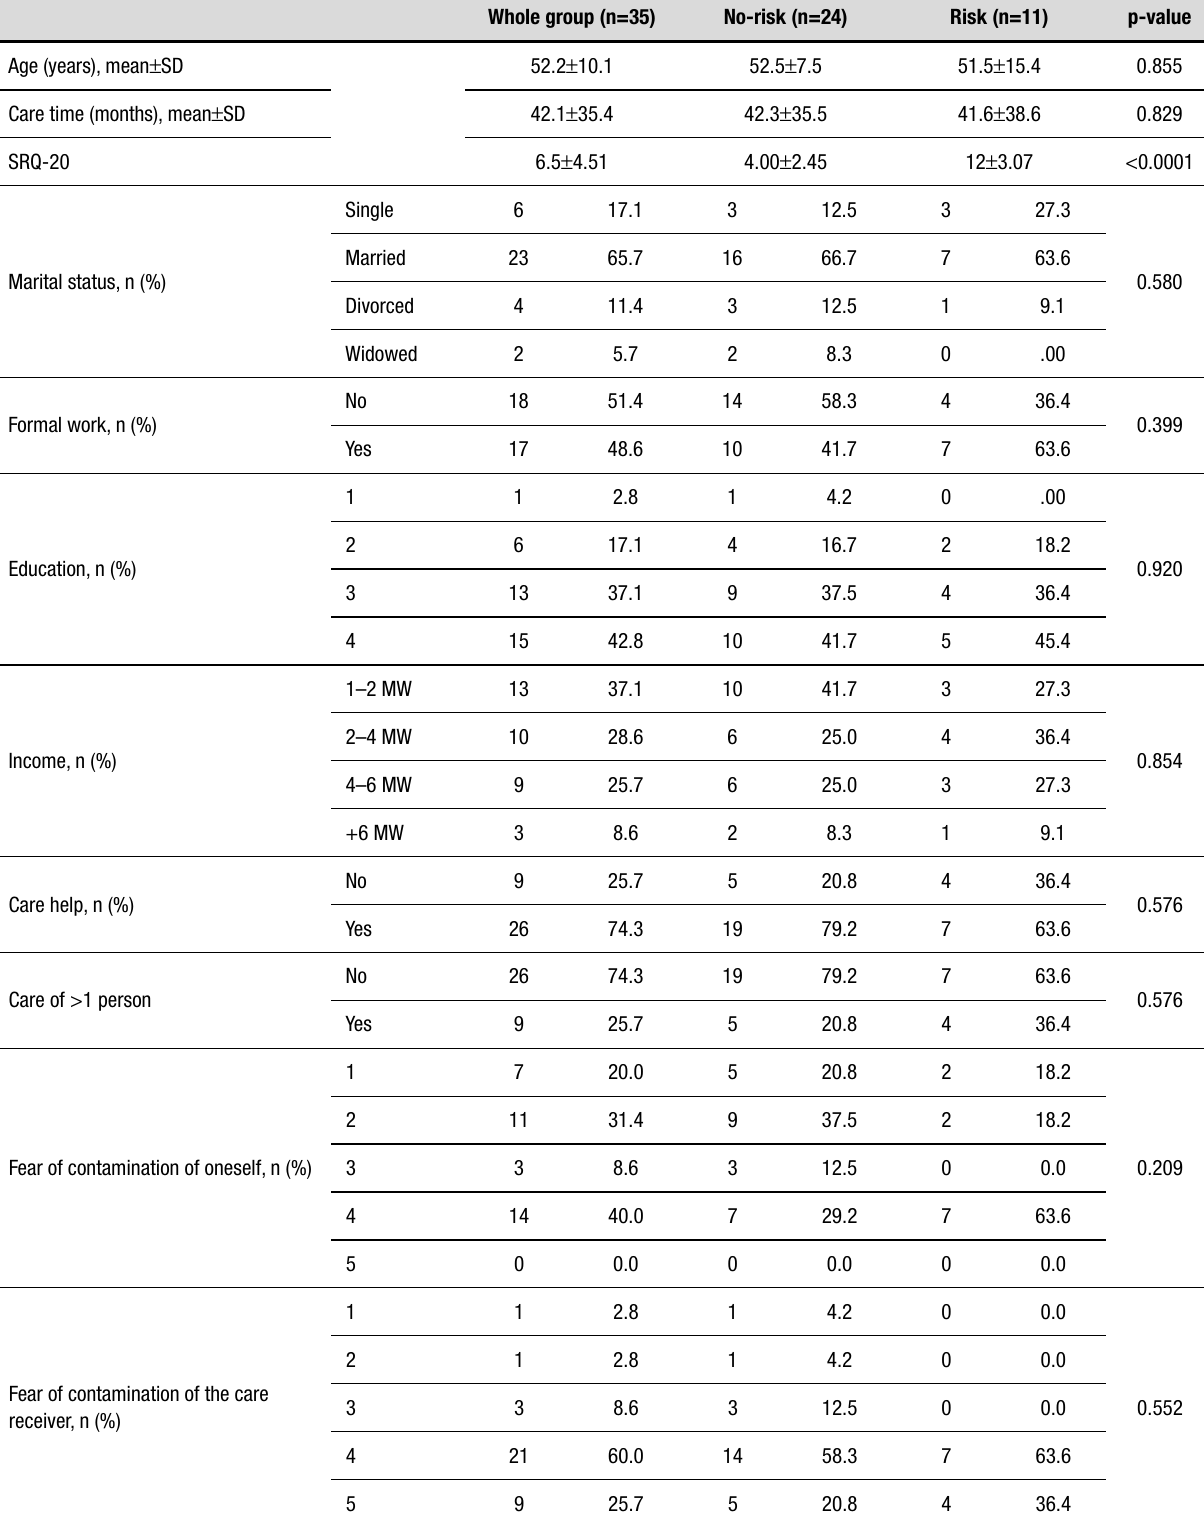
Table 1. Variables relating to the characteristics of the caregiver to the whole group and according to the risk classification defined by the SRQ-20 instrument (No-Risk and Risk for mental